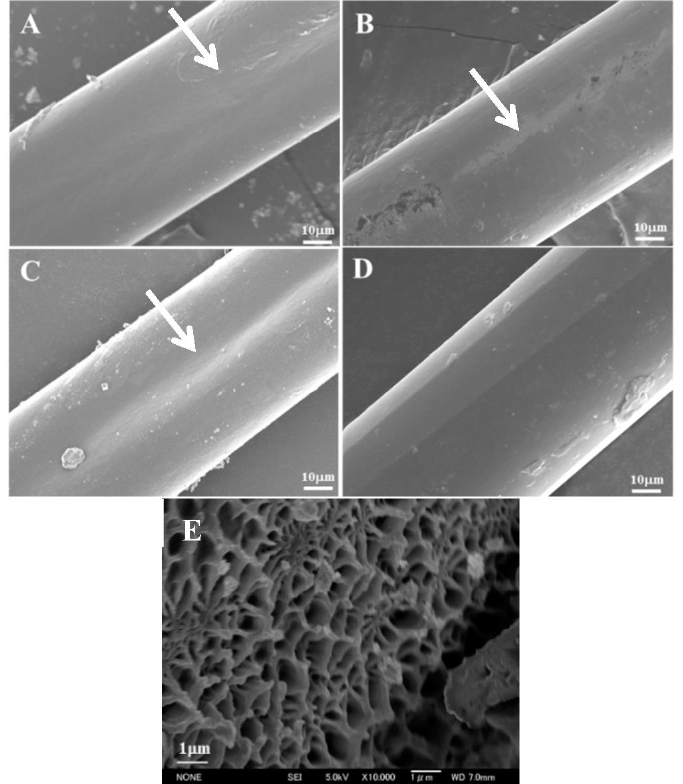
Figure 3. SEM images of ( A ) gelatin fiber without crosslinking; ( B ) GlcNAc-crosslinked fiber; ( C ) denacol-crosslinked fiber; ( D ) GTA-treated fiber; and ( E ) the cross-section of the gelatin fiber without crosslinking (high magnification).